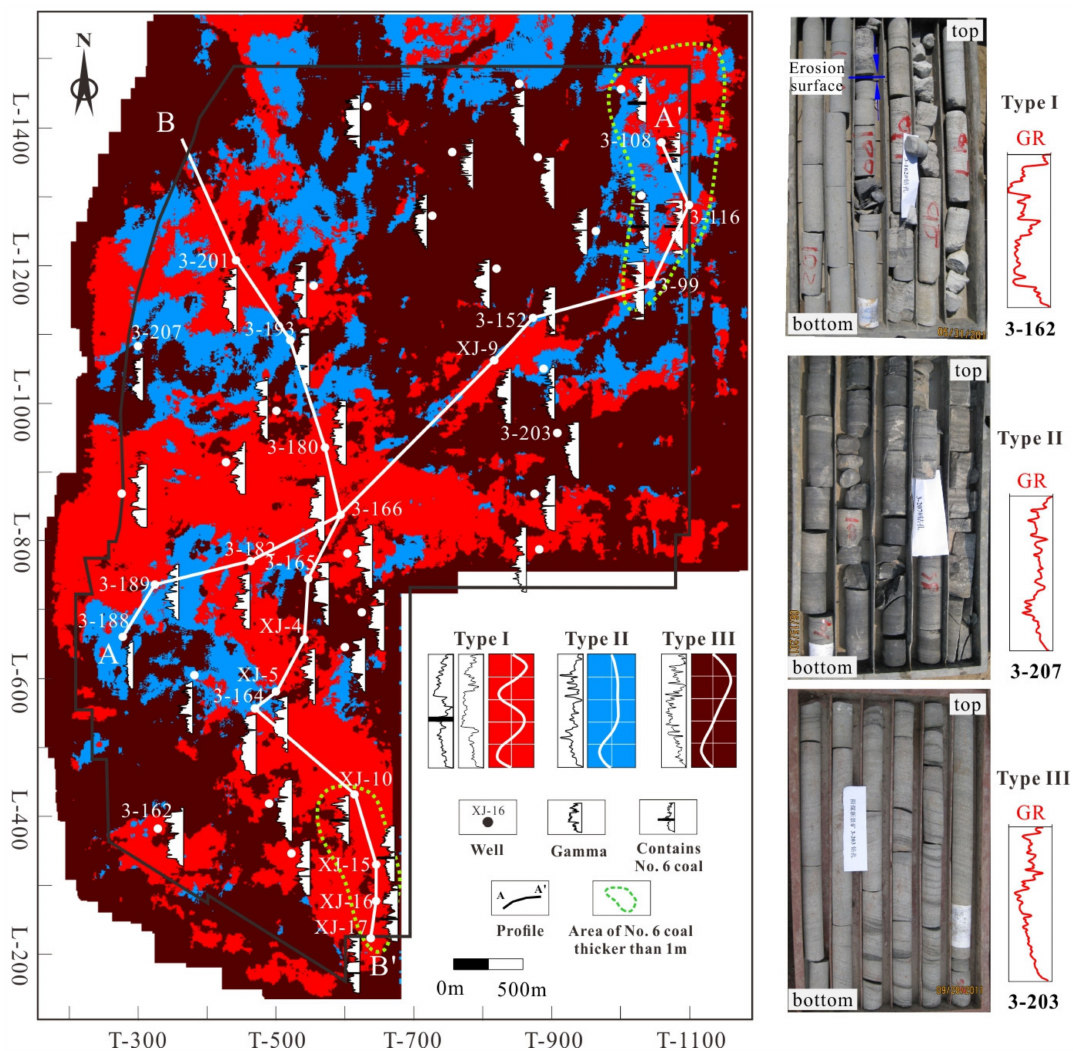
Figure 8. Waveform clustering results of the SS1 sequence, core and logging curve form characteristics. Type I represents distributary channel or backswamp facies. Type II refers to natural levee and crevasse splay facies. Type III reflects river mouth bar